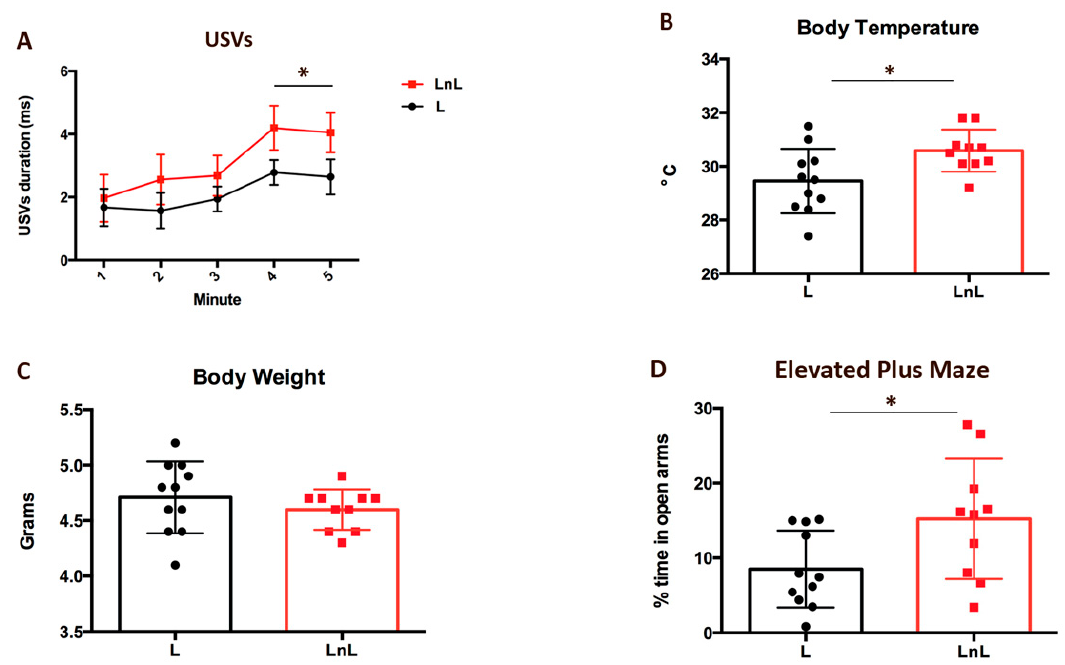
Figure 3. LnL condition enhances resilience in 8-day-old pups and reduces anxiety in biological mothers. ( A ) Duration (mean ± SEM) of ultrasonic vocalizations (USVs) emitted from L and LnL pups during 5 min isolation. (* p = 0.05, one-way Anova for repeated measures, with time as within factor); ( B ) body temperature (mean ± SEM) of L and LnL pups after 20 min isolation (* p < 0.05, two-tailed unpaired t -test). ( C ) body weight (mean ± SEM) of L and LnL pups (n.s.; two-tailed unpaired t -test) ( D ) percentage of time spent in open arms (mean ± SEM) of an elevated plus maze by biological mothers from L and LnL groups (* p < 0.05; two-tailed unpaired t -test). In addition, pups’ body temperature was comparable between groups before USVs (30.01 ± 0.25 ◦ C in L mice and 29.98 ± 0.21 ◦ C in LnL mice, t (24) = 0.106; p = 0.916, n.s.) and dropped down similarly during the 5 min interval for USVs (28.55 ± 0.29 ◦ C in L mice;